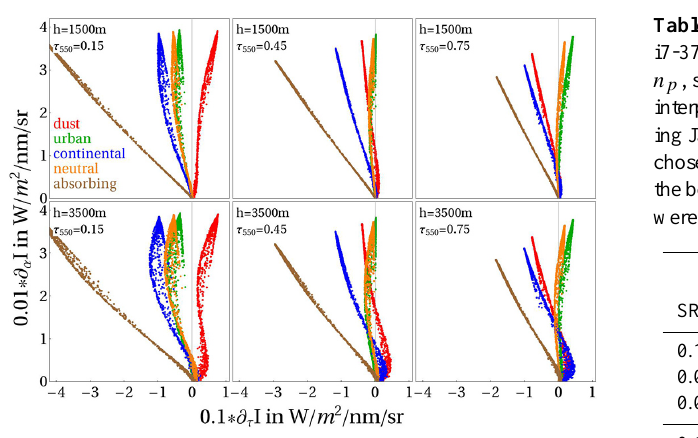
Figure 7. Similar setup to that shown in Fig. 7, but the partial derivatives with respect to surface reflectivity and aerosol optical thickness are compared.